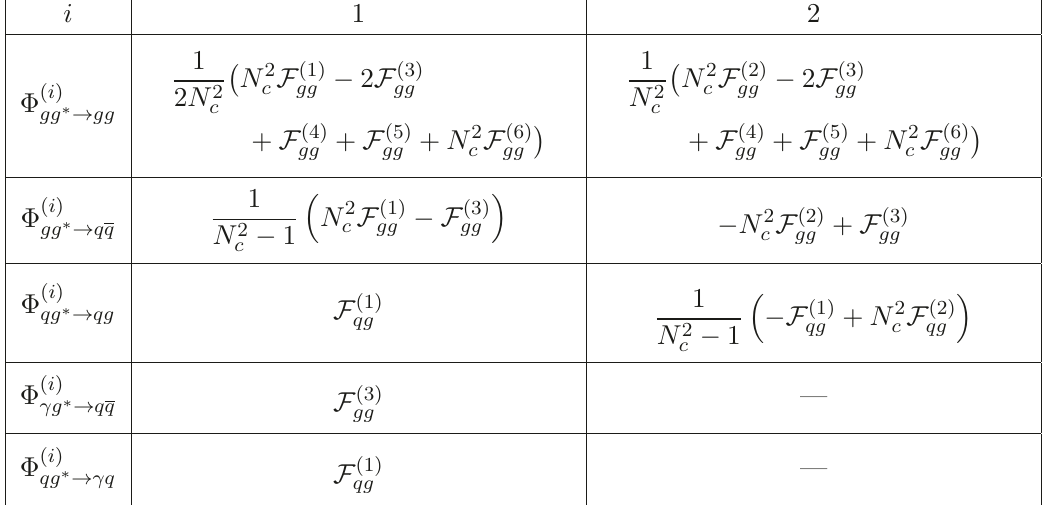
Table 1 . The TMD gluon distributions corresponding to the hard factors ˜